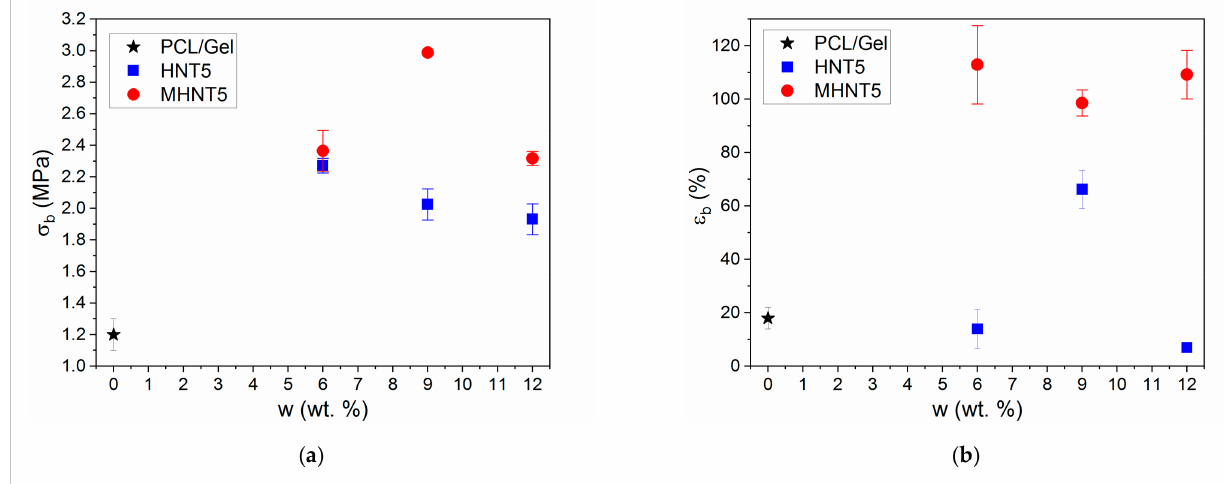
Figure 7. Tensile strength ( a ) and elongation at break ( b ) results for PCL/Gel nanofibers with HNT and MHNT particles at various